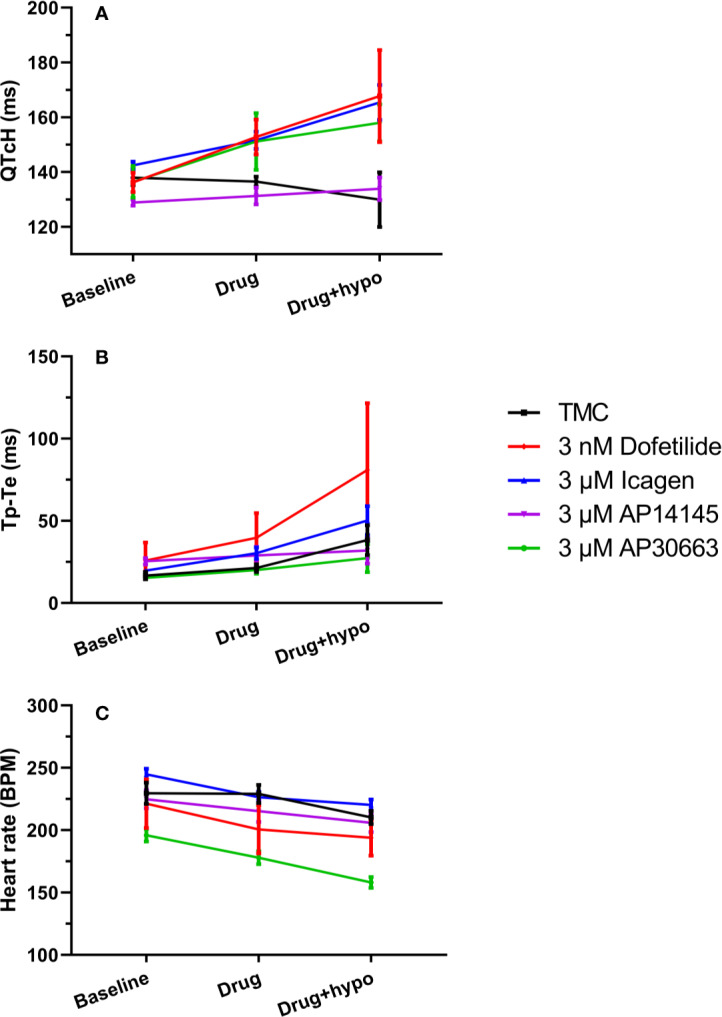
KCa2 channel inhibitors prolong QTc and Tp-Te intervals, and decrease heart rate to a variable degree. (A) Changes in the QT interval corrected for heart rate (QTcH) (B) Changes ins the Tp-Te interval and (C) heart rate in the five groups. Data are presented as mean ± SEM. For QTc and heart rate: N = 6 except for measurement during hypokalemia where n = 5 for ICA and n = 4 for TMC and dofetilide because of spontaneous ventricular fibrillation. TMC, time-matched control.